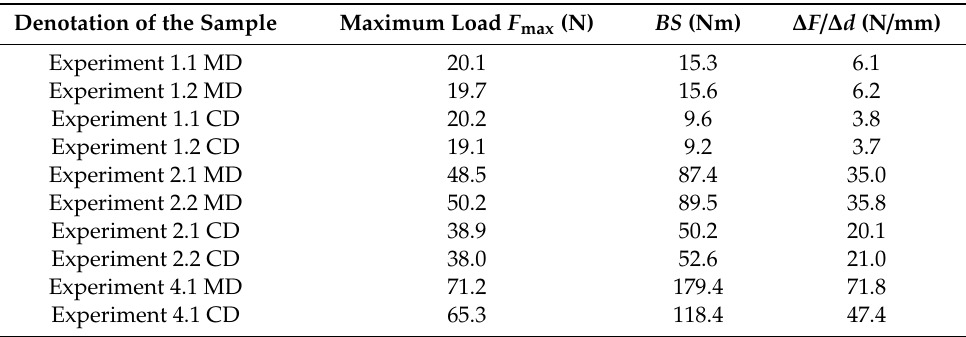
Table 4. Results of the